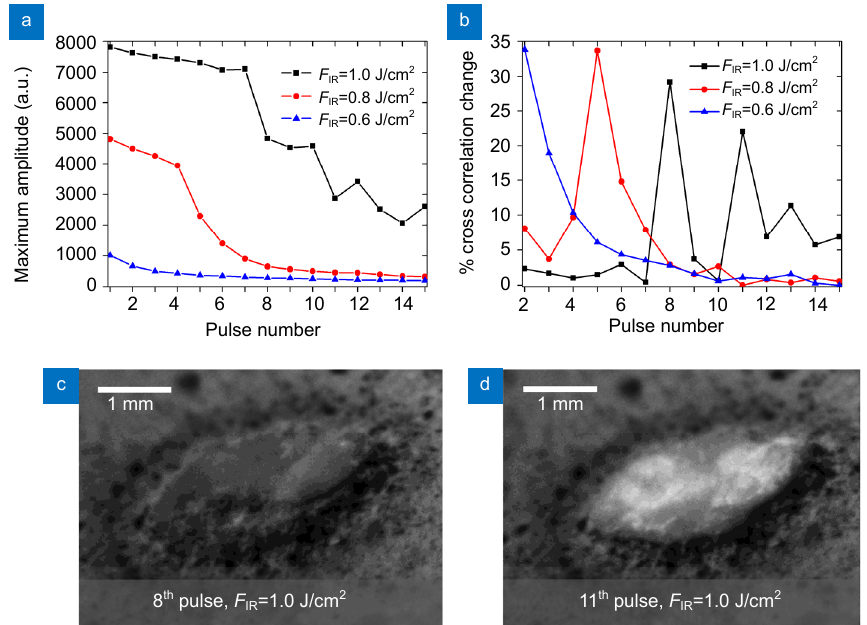
Fig. 3 | ( a ) Maximum amplitude of cross correlation product for three different fluence values as a function of pulse number. ( b ) Maximum ampli- tude percentage change. ( c ) Optical image corresponding to the 8th laser pulse. ( d ) Optical image corresponding to the 11th laser pulse. For both cases, irradiation fluence has been equal to 1.0 J/cm 2 .